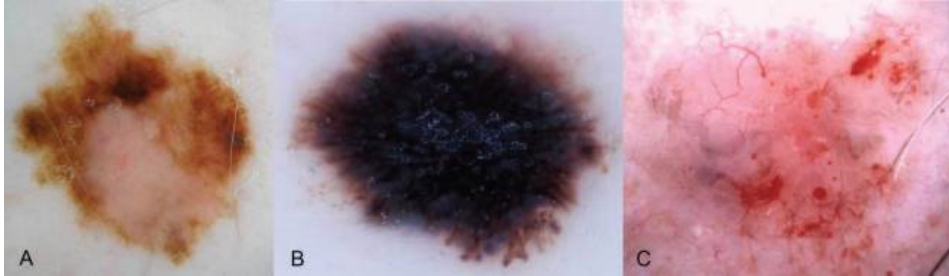
Figure 3. Dermoscopic images: ( A ) Dysplastic Nevus; ( B ) Melanoma in Situ; ( C ) Basal Cell Carcinoma (low grade-nodular type) [28].